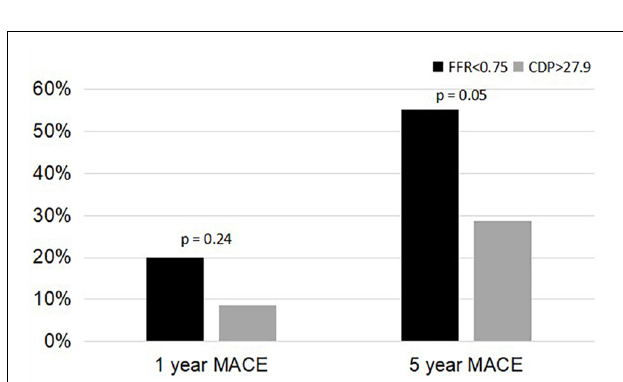
FIGURE 3 | Comparison of %MACE between the FFR < 0.75 group and the CDP > 27.9 groups at 1 and 5 years. MACE, major adverse cardiac events; CDP, pressure drop coefficient; FFR, fractional flow reserve.